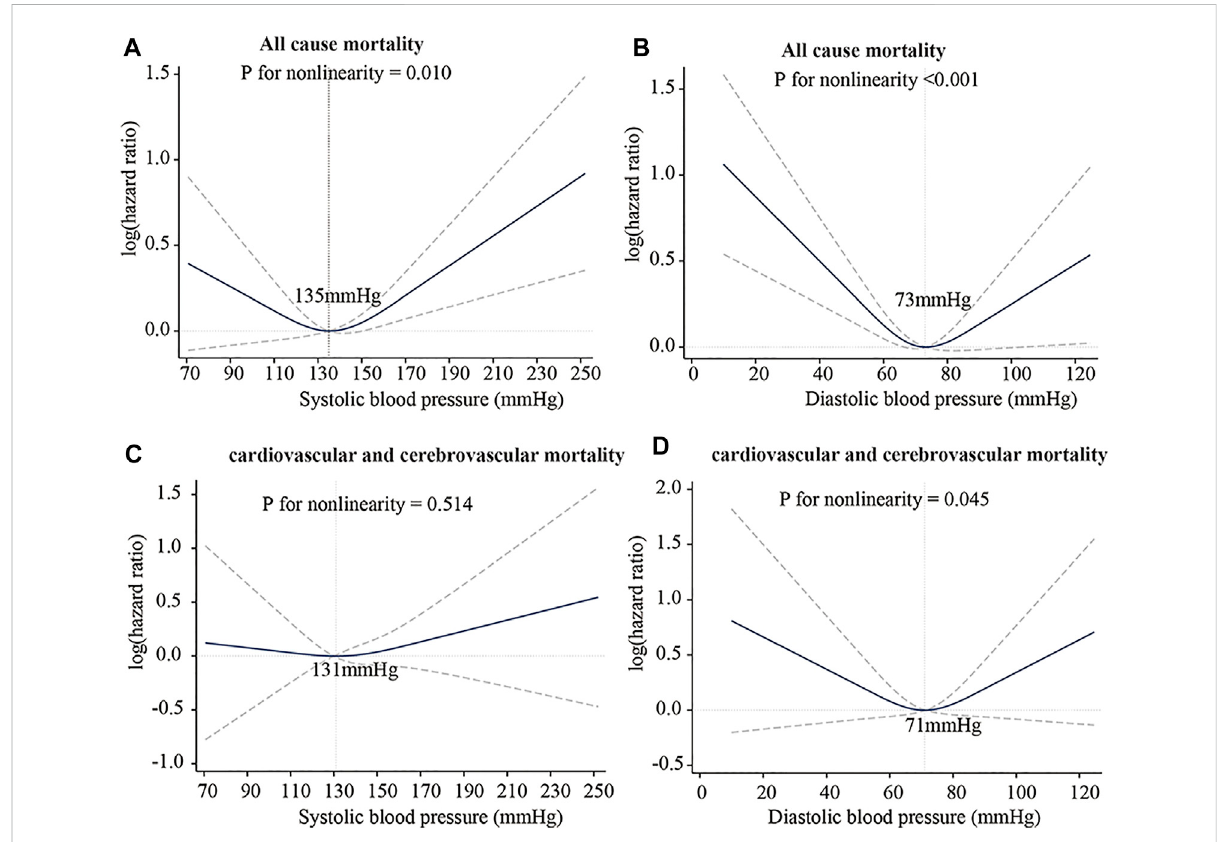
FIGURE 7 J-Curve of the association between blood pressure and risk of death. (A) SBP: all-cause mortality. (B) DBP: all-cause mortality. (C) SBP: cardiovascular and cerebrovascular mortality. (D) DBP: cardiovascular and cerebrovascular mortality. International Journal of General Medicine 2021:14 5039-5049 Originally published by and used with permission from Dove Medical Press